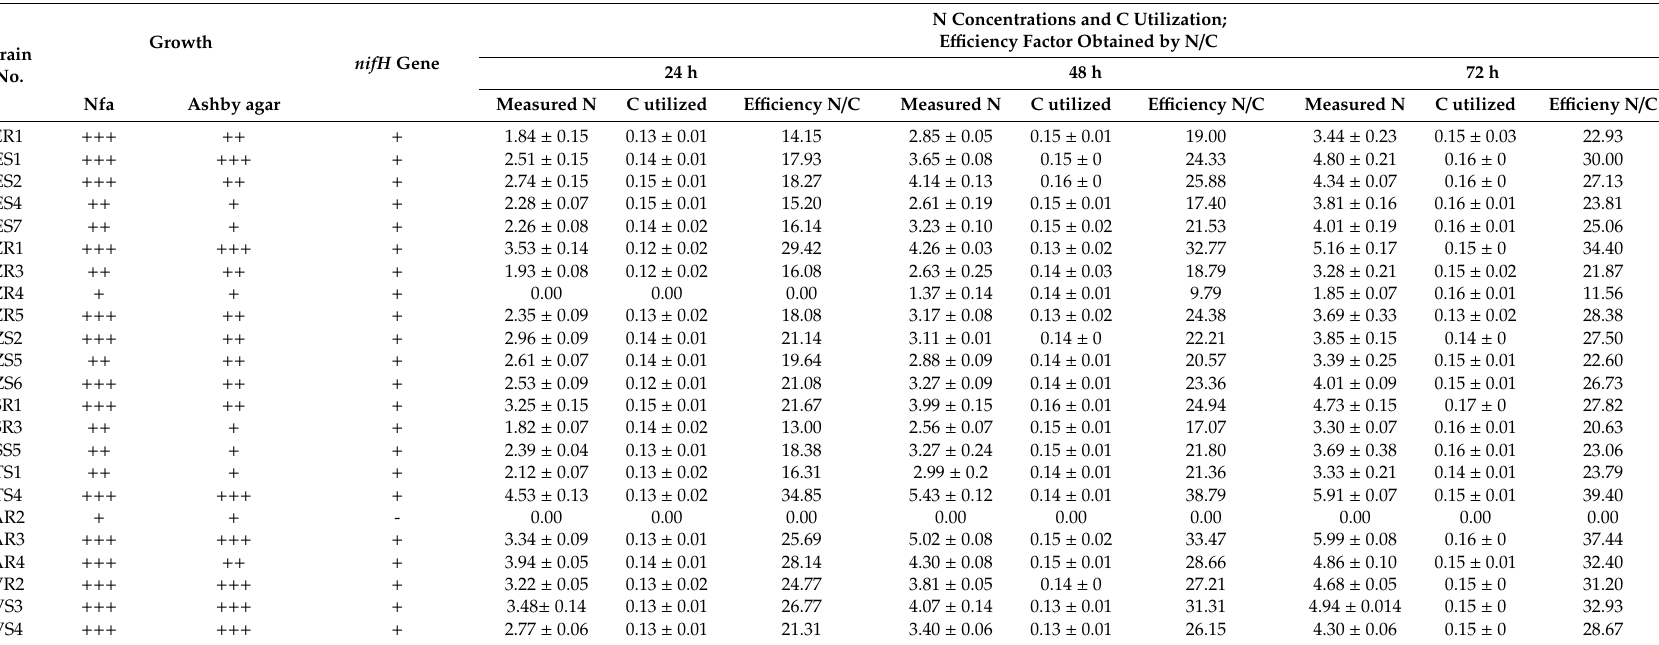
Table 3. Results of analysis regarding nitrogen fixing by tested bacteria (growth on Nfa and Ashby medium, presence of the nifH gene and e ffi ciency of nitrogen fixing using the Kjeldahl